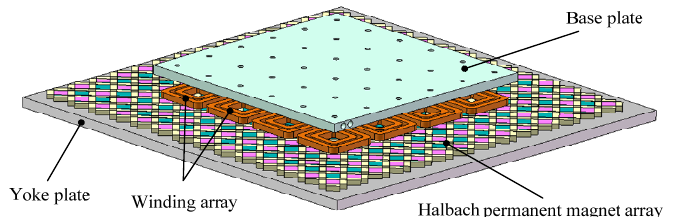
Figure 1. The maglev planar motor structure.